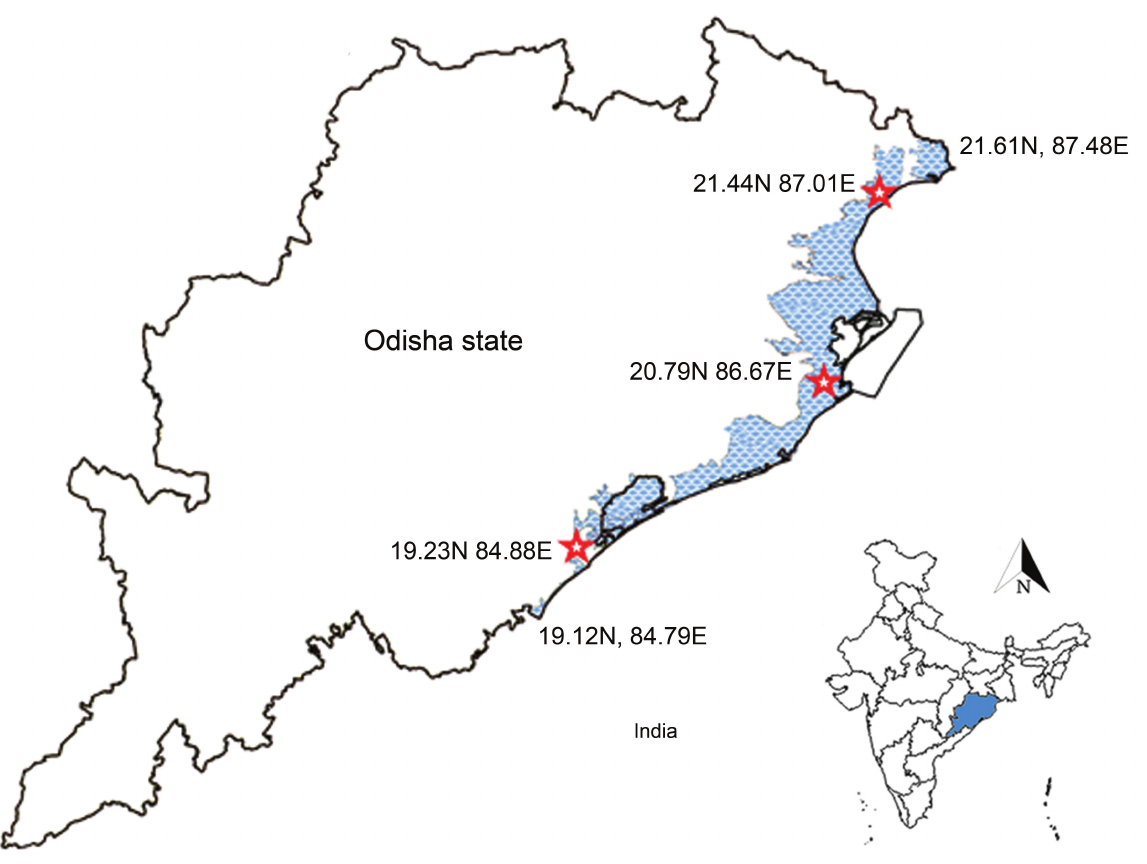
Figure 1: Map showing the coastal region of Odisha state by Blue dots and collection localities by Red star marks. The geographic coordinates of the coastal region and the sampling sites are superimposed on the map. The map of India is added on inset with marking of the Odisha state by blue